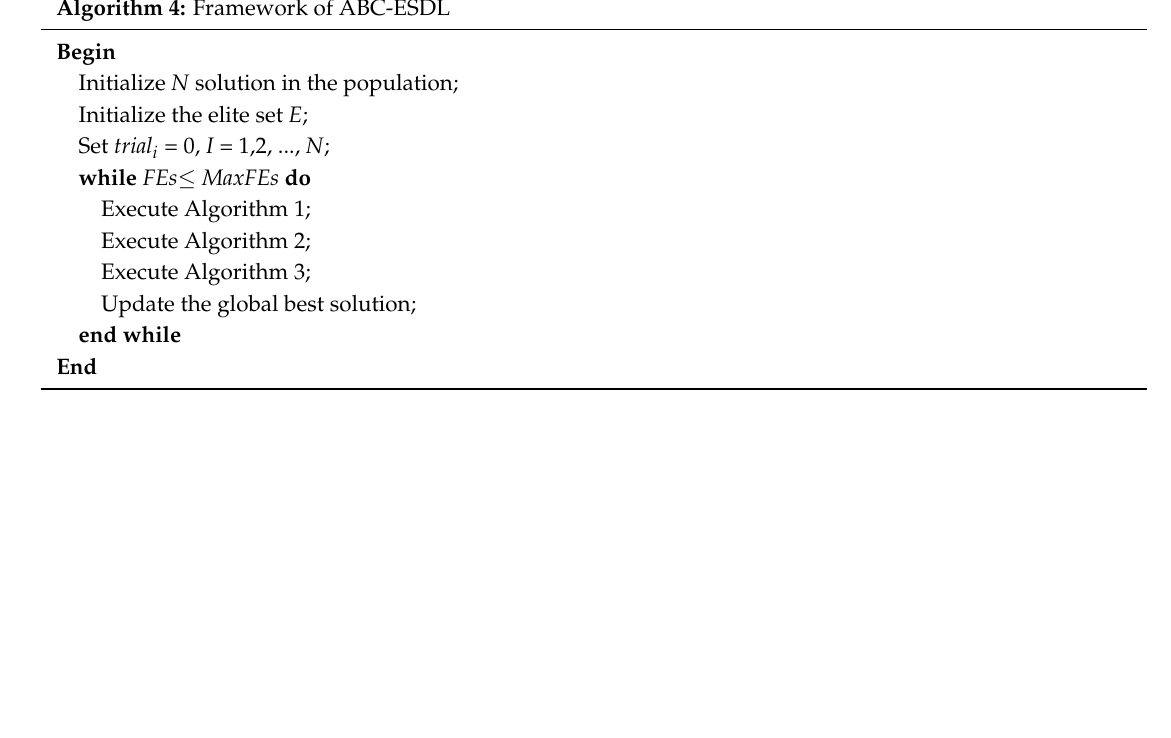
Algorithm 4: Framework of